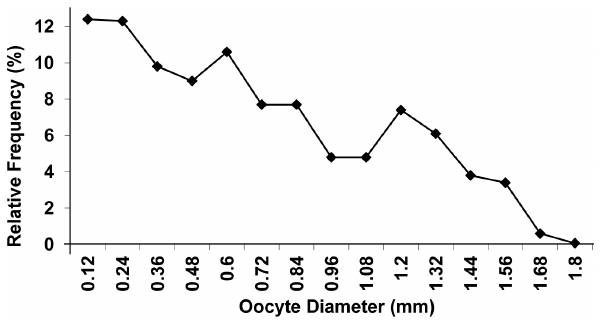
Figure 3. Spawning type. Distribution of the relative frequency of oocyte diameters of Brachyhypopomus gauderio mature females. Number of specimens analyzed= 09.